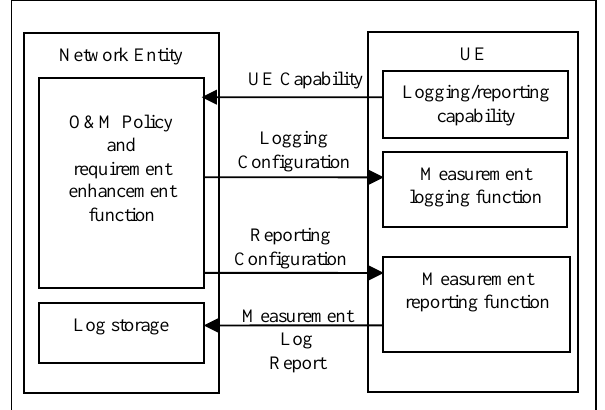
Figure 2 . UE Feedback